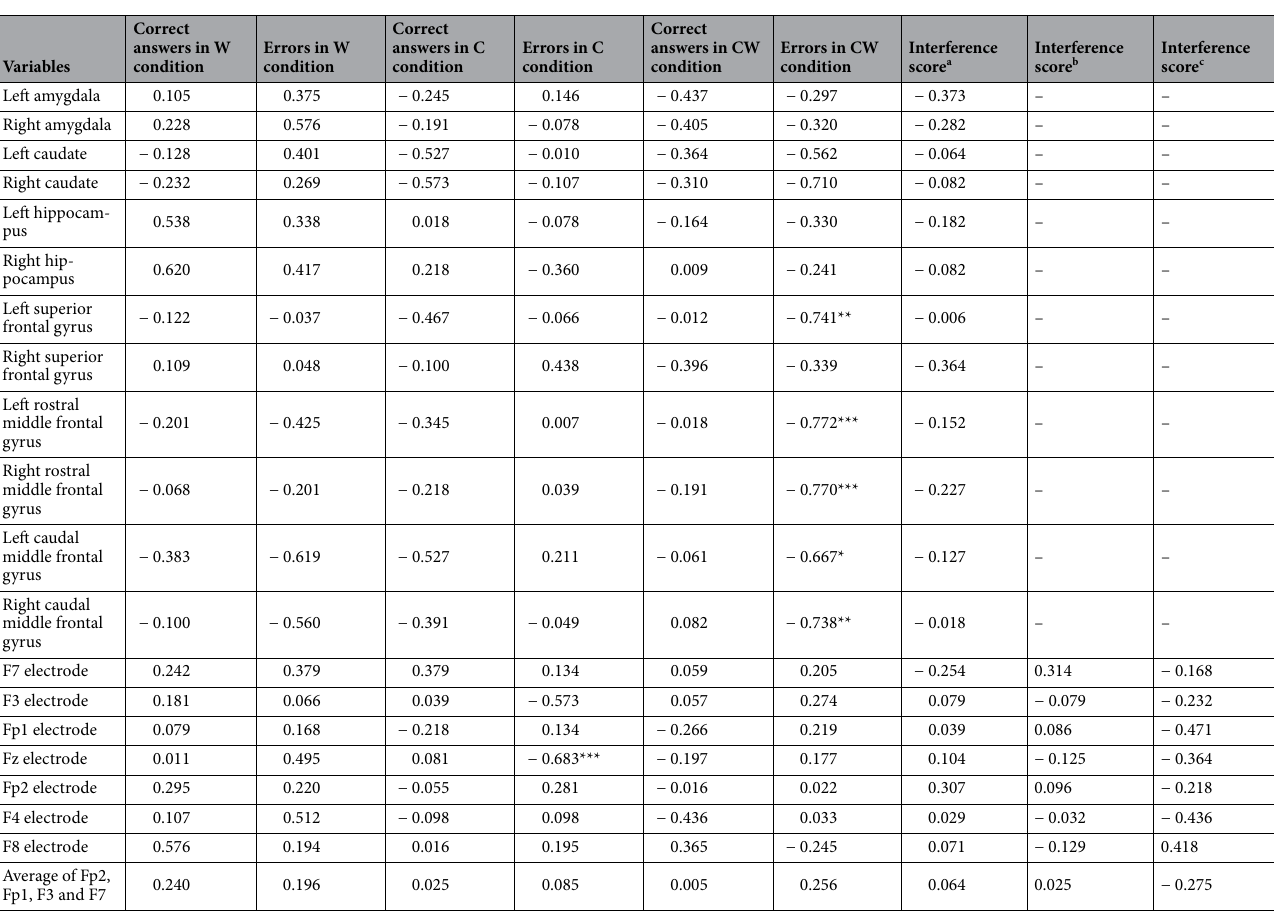
Table 5. Correlations between SCWT performance and MRI structures and frontal EEG theta power spectrum in non-physically active women with fibromyalgia. W names of colors printed in black, C